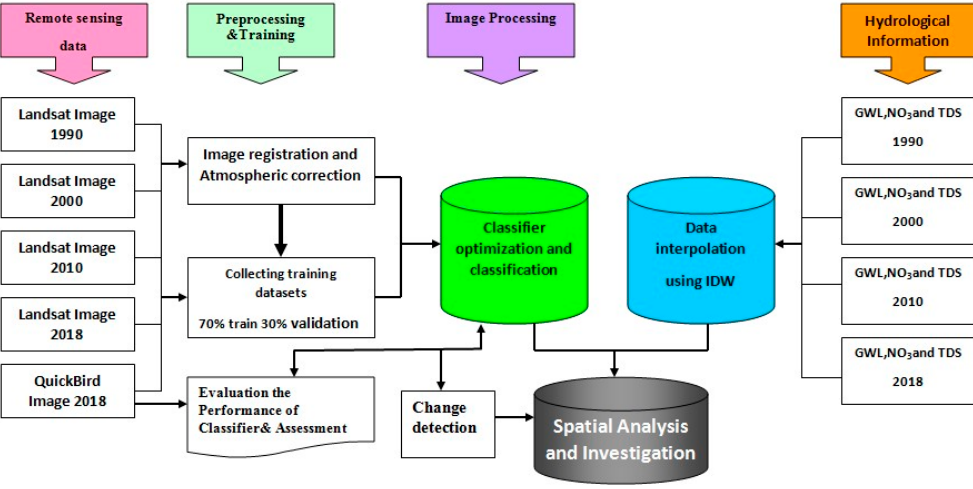
Figure 4. Flowchart of the methodology applied to the study area.